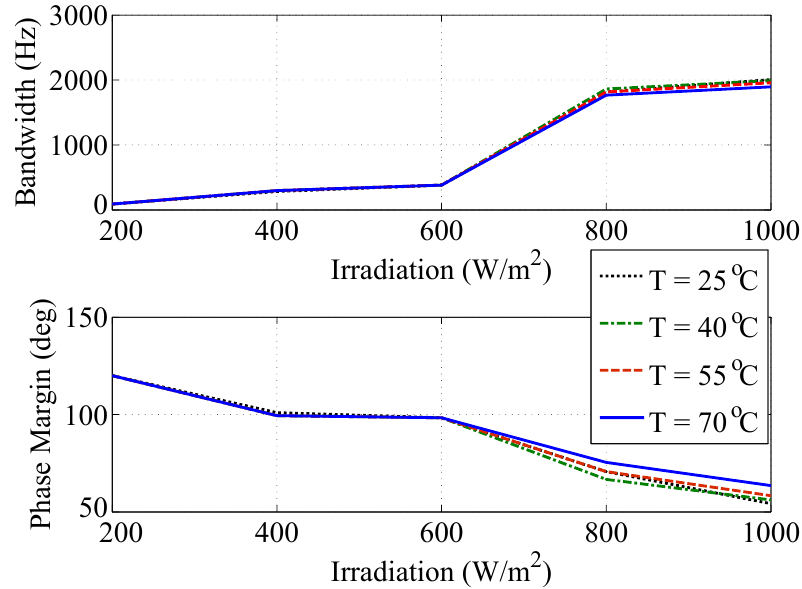
Figure 7. Variation in phase margin and bandwidth with ambient conditions, namely, irradiation and temperature, for maximum power point operation corresponding to 0.6 duty ratio here. Table 2. Variation in controller parameters with changing ambient conditions of irradiation ( G ) and temperature ( T ) for complete duty ratio ( d )